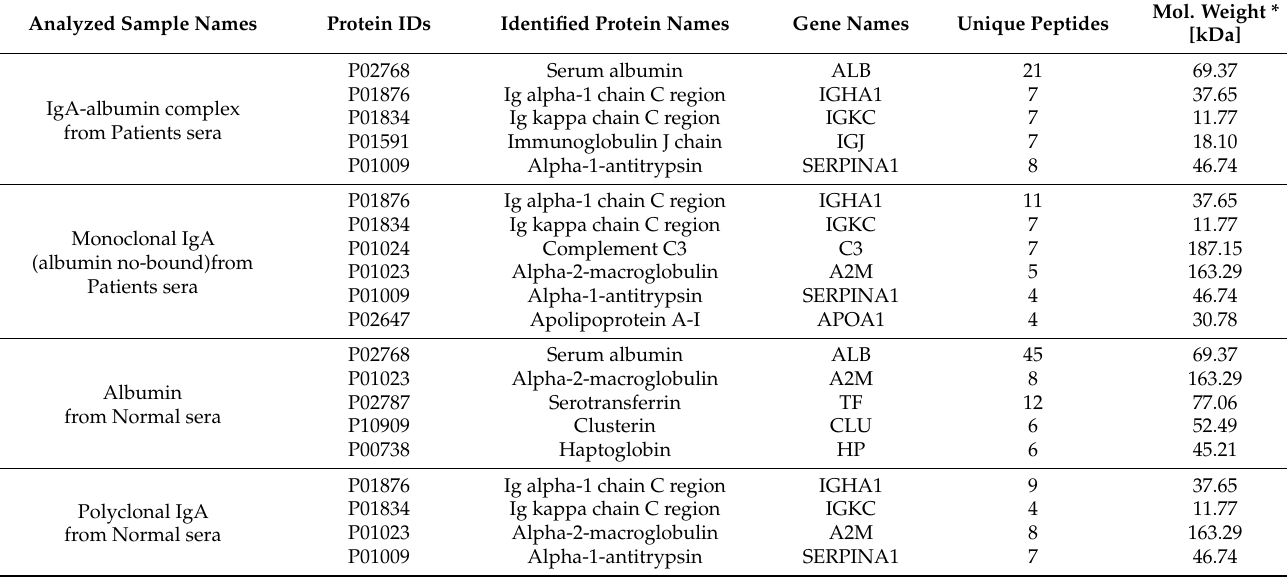
Table 1. Proteins identified by mass spectrometry from each purification step (IgA-albumin complex, monoclonal IgA, albumin and polyclonal IgA).